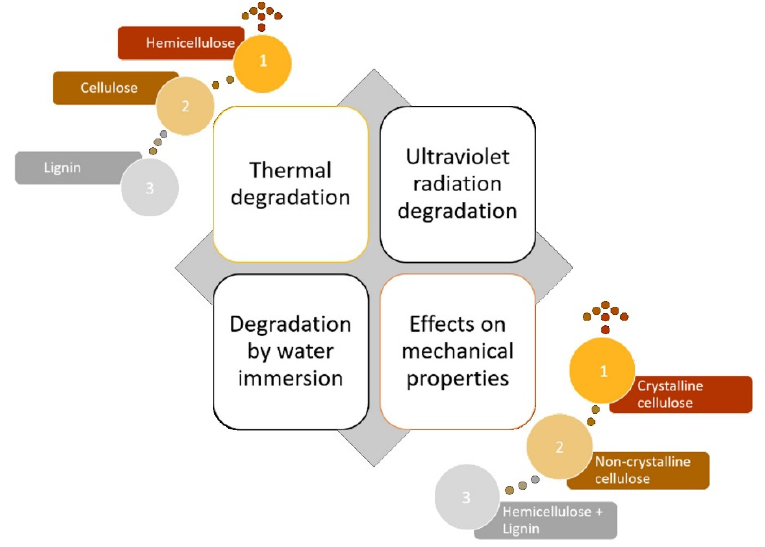
Figure 4. Main components of natural fibers and their orderly influence for thermal degradation and mechanical properties.